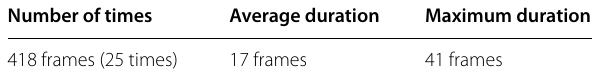
Table 6 The details of occlusion conditions in the on-line experiment Number of times Average duration